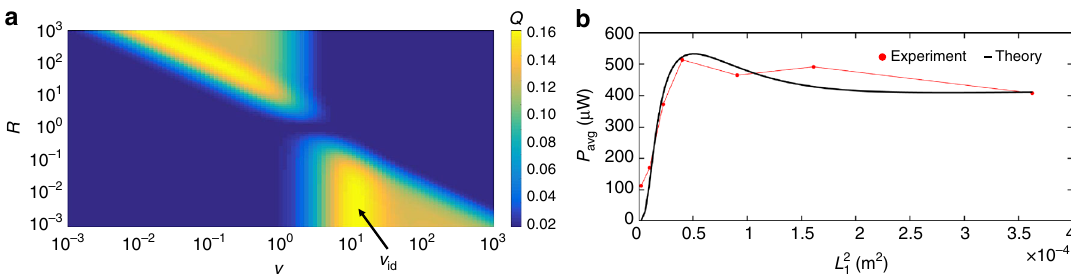
Fig. 5 Theoretical and experimental design of a resonator for personal temperature fl uctuations. a A heat map guiding the design and performance ( Q ) of a thermal resonance device, provided the dimensionless oscillation frequency ð v Þ of the ambient temperature bath and the ratio of thermal mass diffusion time scales ( R ). b Time-averaged power output ( P avg ) of thermal resonance devices as a function of the square of the length ( L 1 ) of the dominant thermal mass from experiment (red) and fi tted with theory (black) (Methods, Supplementary Note 10). An input, angular temperature oscillation frequency ( ω f ), which corresponds to the frequency of personal temperature oscillations (Fig. 4b), is applied to all systems and is indicated in Supplementary Fig.